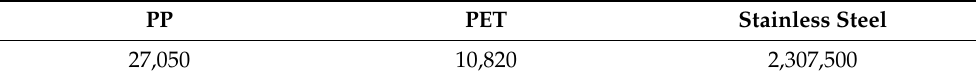
Table 27. Total process waste (kg) per material type by the end of the product lifetime production.